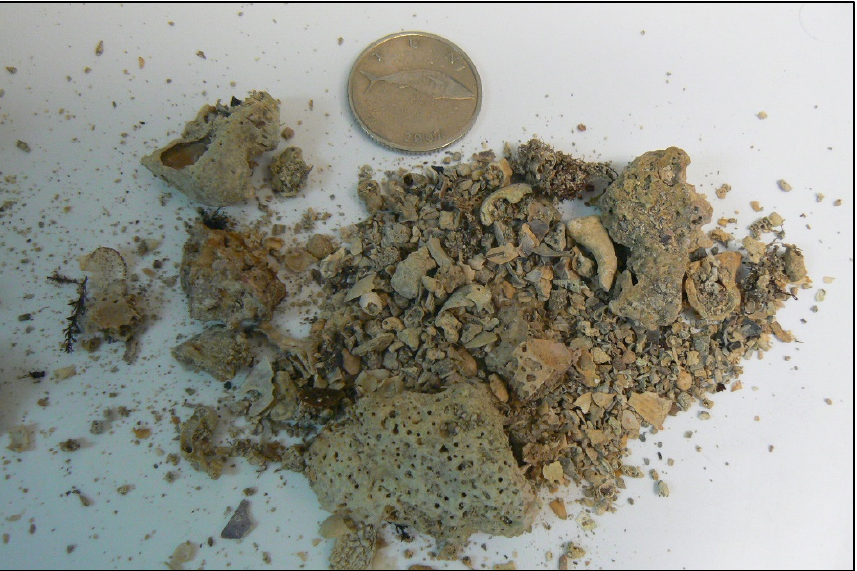
Figure 7. Domination of skeletal debris followed by carbonate litoclasts in a randomly subsampled PR sample collected in September. Coin is 2.4 cm in diameter.